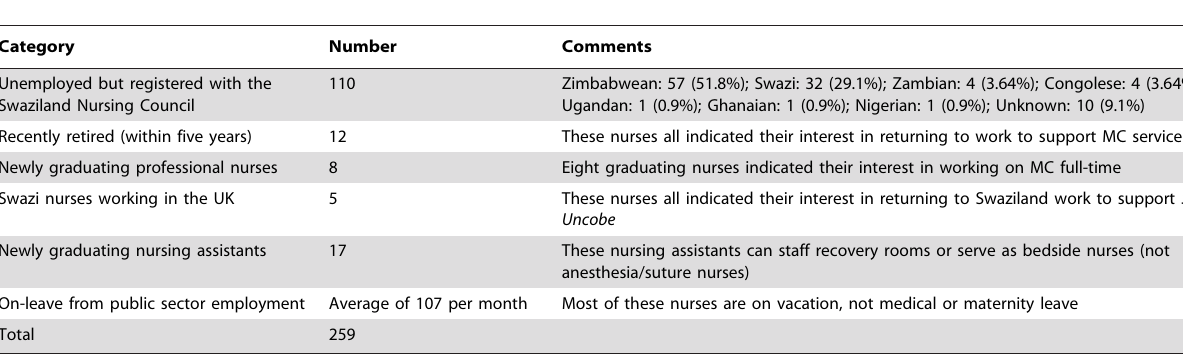
Table 3. Quantification of the nursing workforce in the Kingdom of